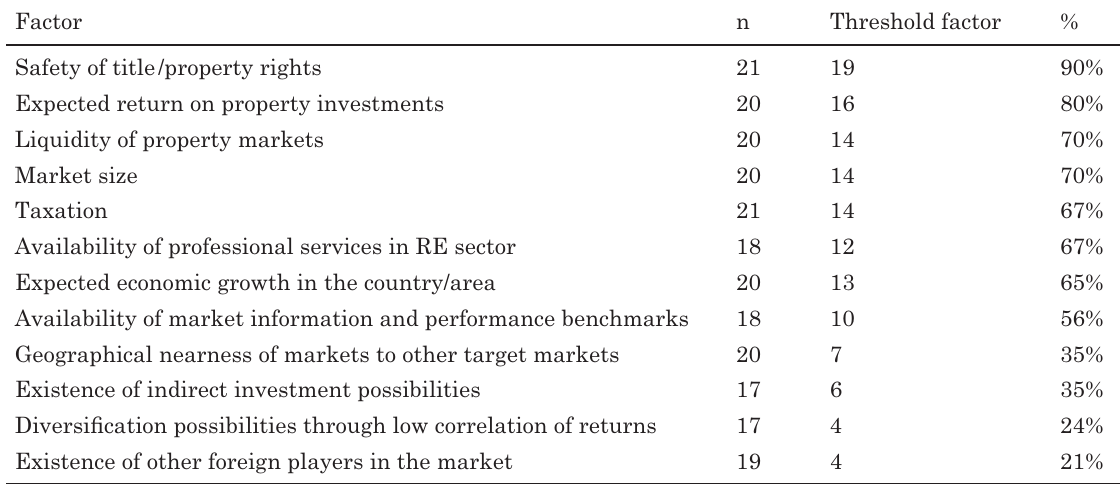
Table 7. Factors acting as threshold condition in market selection process Factor